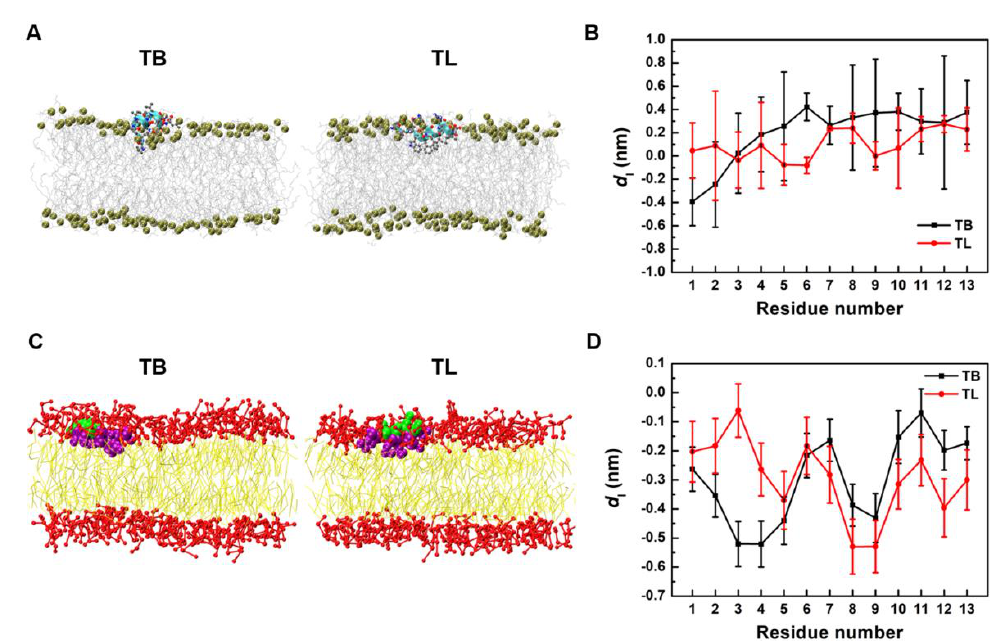
Figure 5. ( A ) Snapshots of binding states of TB and TL monomers on membranes obtained from AA simulations. ( B ) Insertion depth d I of C α atoms of TB and TL monomers into membrane in AA simulations. ( C ) Snapshots of binding states of TB and TL monomers on membranes obtained from CG simulations. ( D ) Penetration depth of backbone beads of TB and TL monomer into membrane in CG simulations.